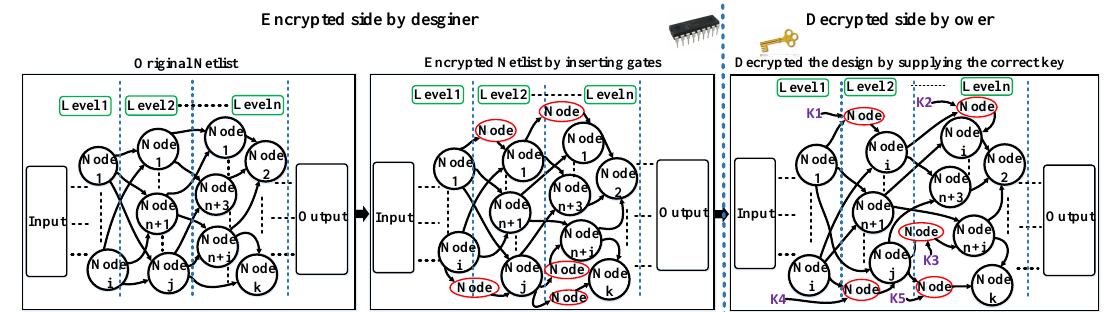
Figure 1. The basic concept of the encrypted and decrypted logic